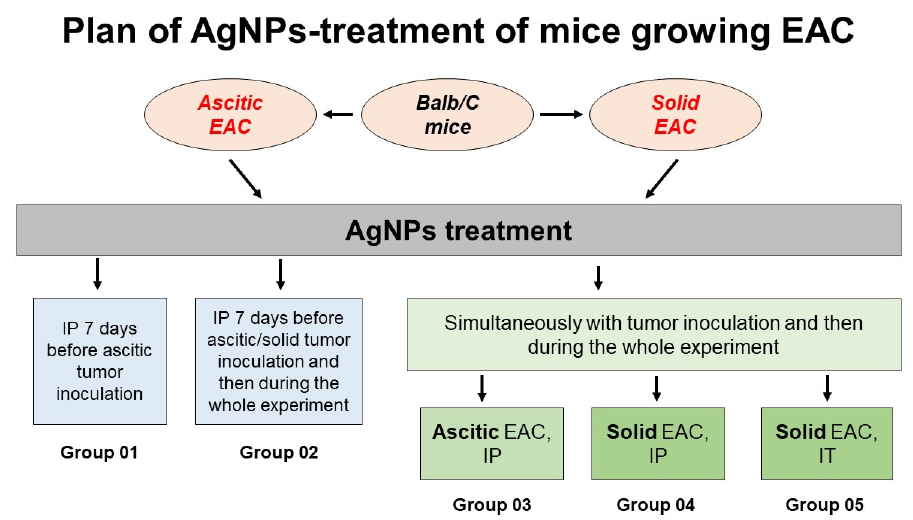
Figure 4. Plan of AgNP treatment of mice growing EAC tumors and numbering of experimental groups. Group 02 includes two subgroups: mice bearing ascitic EAC and solid EAC. In groups 01 and 03, 1 × 10 6 EAC cells were injected intraperitoneally (IP); in groups 04 and 05, 1 × 10 6 EAC cells were injected in the right thigh. Mice of 01–04 groups were treated with AgNPs intraperitoneally (100 µL of 3.5 mM AgNPs’ solution per mice). Mice of group 05 were treated with AgNPs inside growing tumors (10 µL of 3.5 mM AgNPs’ solution per mice). Each group consisted of 18 animals.